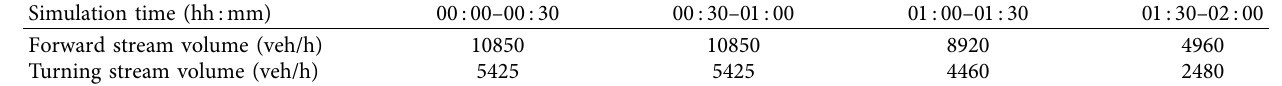
Table 3: Traffic demand of each stream direction over simulation time.